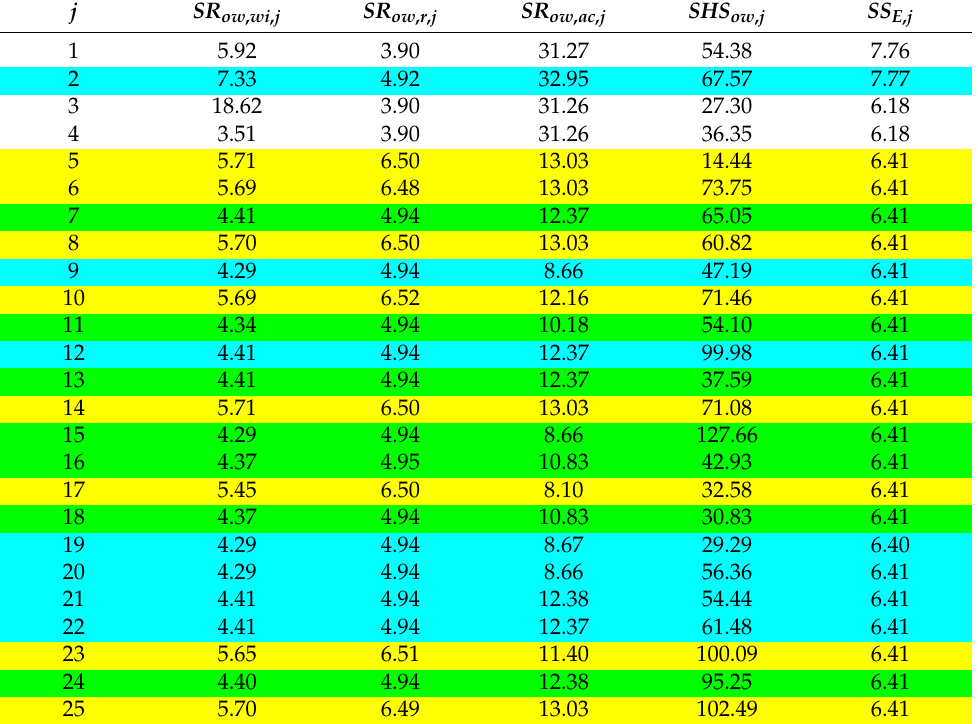
Table 3. Relative energy performance recalculation for individual energy saving measures. SR = sav- ings ratio (kWh/kWh), SHS = specific annual heat savings (kWh/m 2 ), SS E = specific electricity consumption reduction due to lighting refit (W/m 2 ). j = building number ( j = 1 to 25), ow = outer walls insulation, wi = windows replacement, r = roof insulation, ac = air conditioning unit refit. Color code: yellow—single floor building, green—two-story building, light blue—three-story building, white—four- or five-story